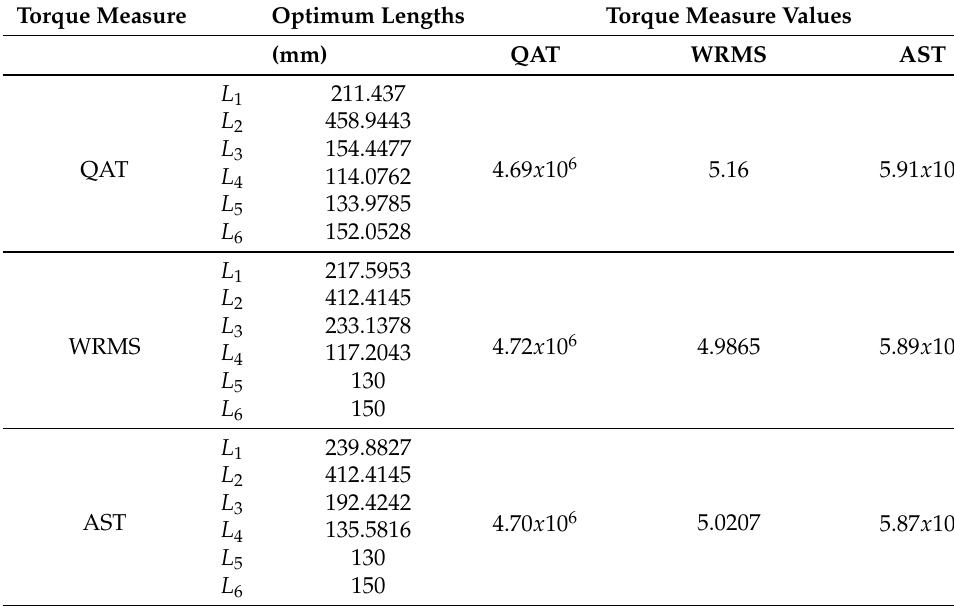
Table 5. Comparison of link lengths and optimal